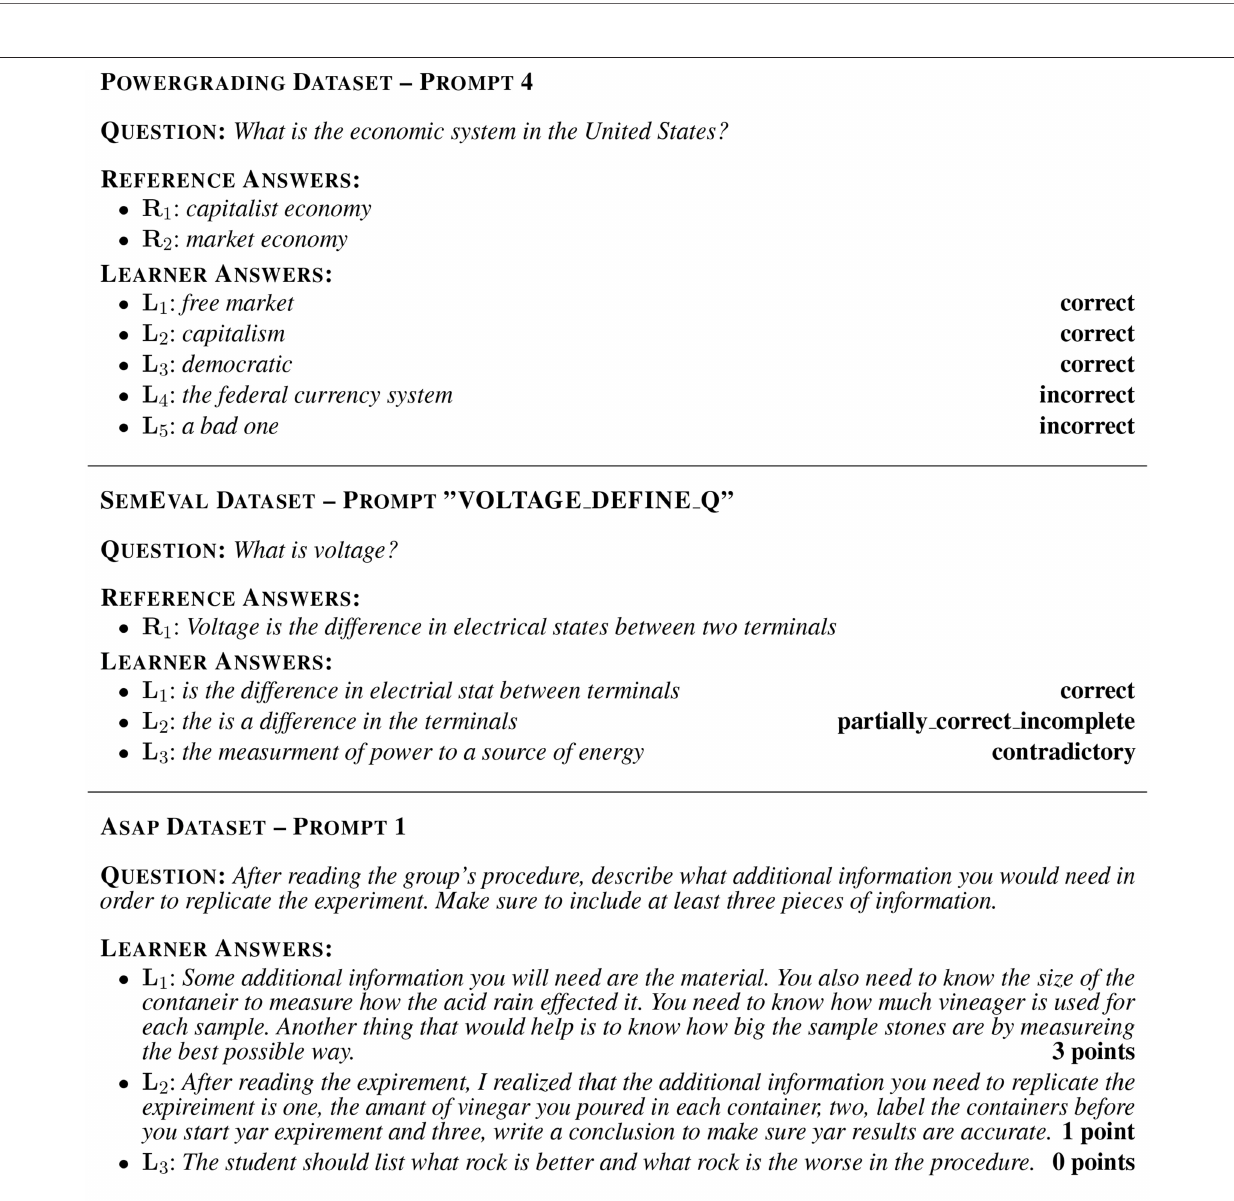
FIGURE 1 | Exemplary content scoring prompts from three different datasets with reference answers (if available) as well as several learner answers with their scoring